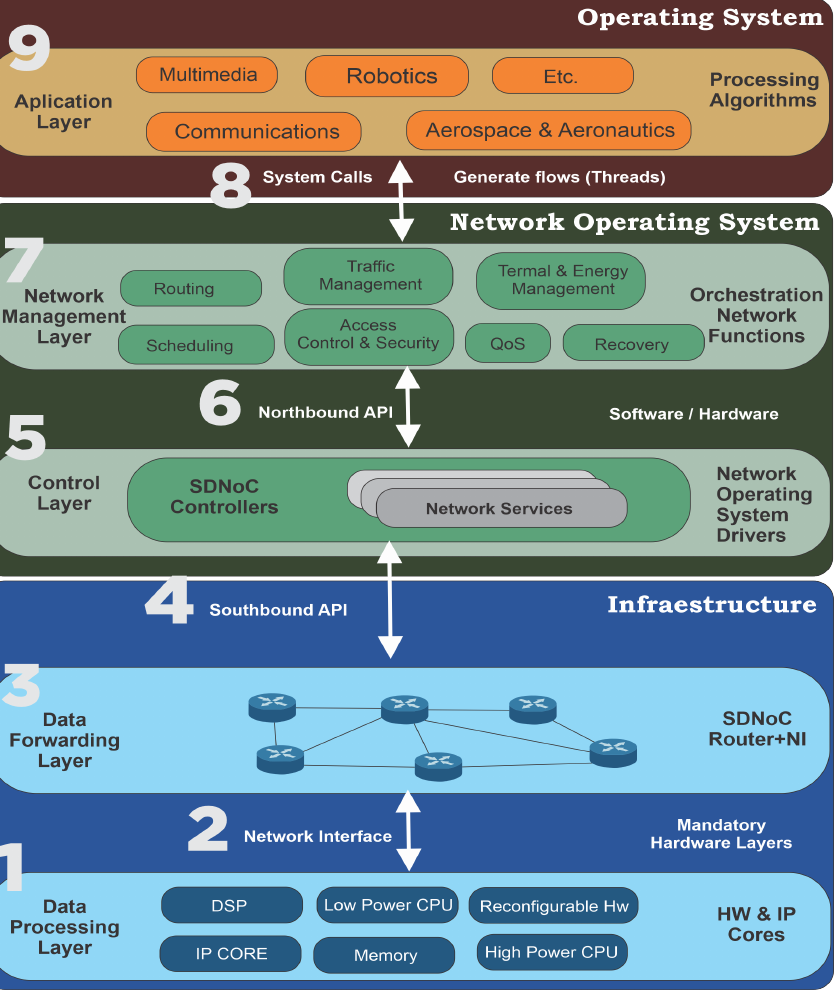
Figure 3. Software-Defined Network-on-Chip Architecture. Odd numbers represent the layers, and even numbers represent the HW/SW interfaces. A different color represents each